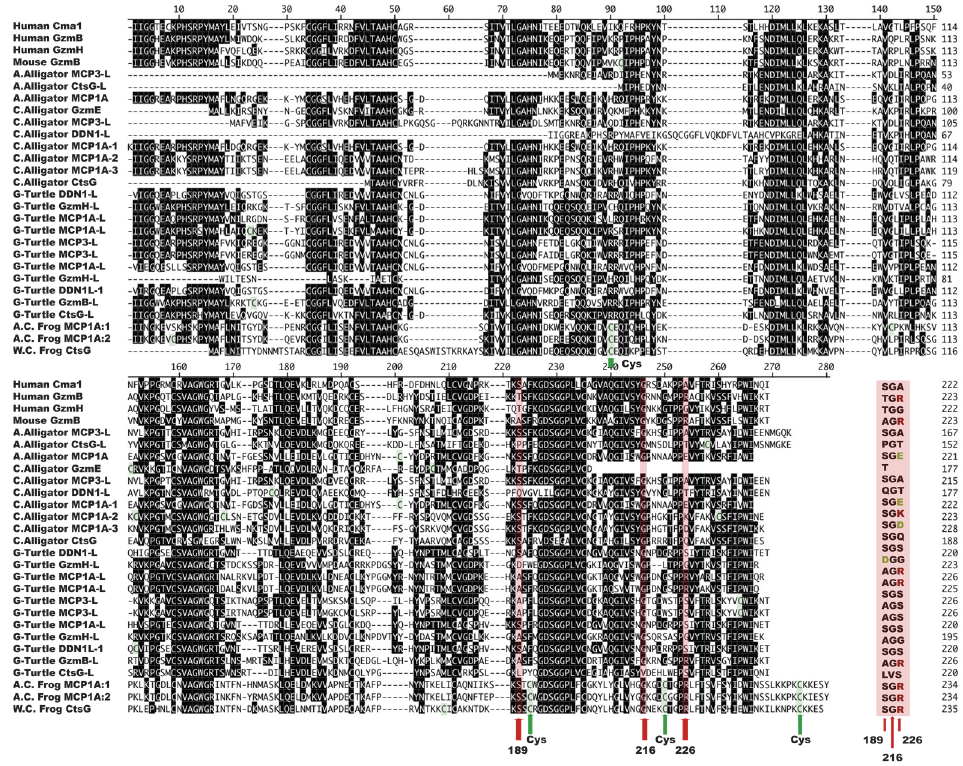
Figure 10. Alignment of the chymase-locus-encoded genes of Figure 2 from reptiles and amphibians. The amino acid sequences of the active protease, lacking a signal sequence and activation peptide, were aligned using the DNASTAR program to visualize the residues forming the S1 pocket of the enzyme. The three amino acids forming the S1 pocket, which can give important information concerning the primary specificity of the enzyme, are marked by red arrows and summarized as the resulting triplet at the end of the figure, marked in pale red. The three residues forming the S1 pocket are residue 189, 216 and 226, following the position numbering of bovine chymotrypsin [38].